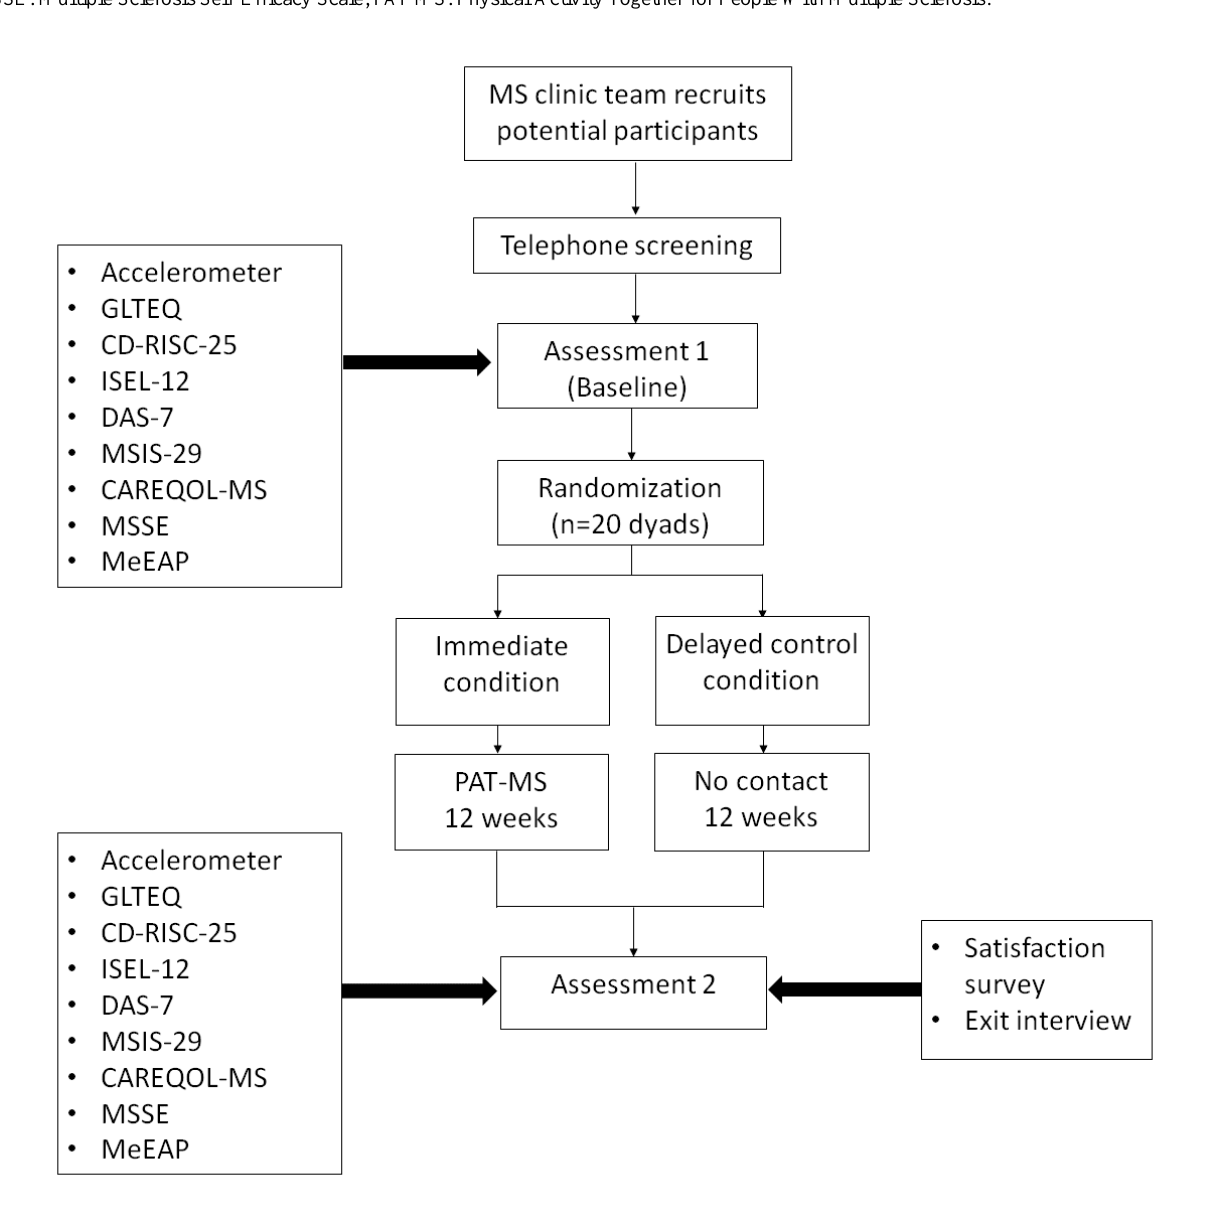
Figure 1. Flow of participants through the study. CAREQOL-MS: Caregiver Quality of Life in Multiple Sclerosis Scale; CD-RISC-10: Connor-Davison Resilience Scale; DAS-7: Short-form Dyadic Adjustment Scale; GLTEQ: Godin Leisure-Time Exercise Questionnaire; ISEL-12: Interpersonal Support Evaluation List-12; MeEAP: Measure of Experiential Aspects of Participation; MS: multiple sclerosis; MSIS-29: Multiple Sclerosis Impact